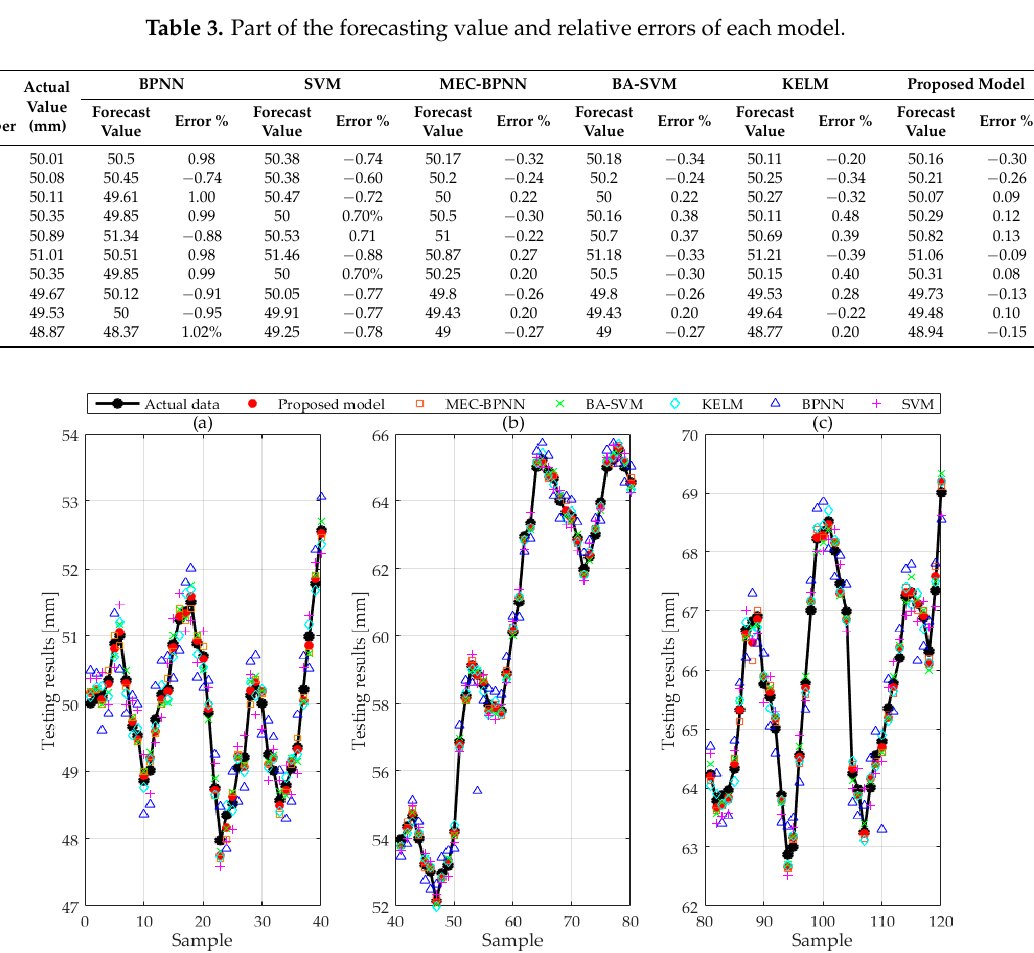
Figure 4. The forecasting values of different methods: ( a ) the forecasting value from 1 to 40 sample point; ( b ) the forecasting value from 41 to 80 sample point; ( c ) the forecasting value from 81 to 120 sample point.